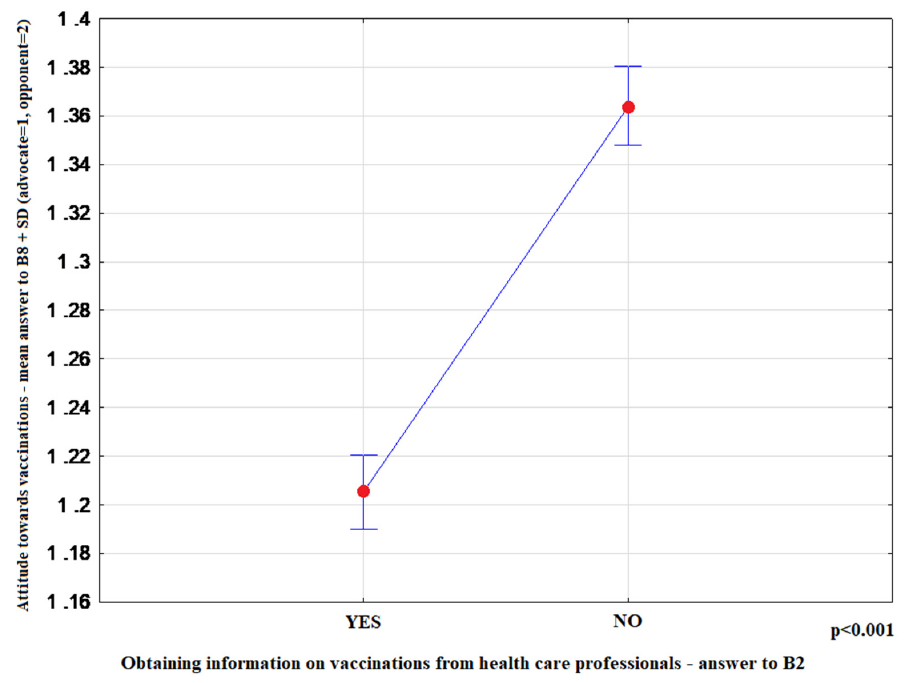
Figure 2. Mean rank ‐ answer to the question about the attitude toward vaccination (B8) + SD depending on the fact of obtaining or not obtaining information on vaccinations from health care professionals (B2) . (Yes n = 3365; No n = 2997).